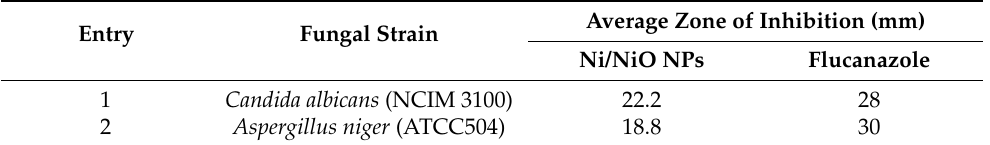
Figure 9. Antifungal effect of biologically synthesized Ni/NiO NPs against ( a ) Candida albicans ( b ) Aspergillus niger and comparative effect of fluconazole (control) against ( c ) Candida albicans ( d ) Aspergillus niger . Table 1. Antifungal effect of biogenically produced Ni/NiO NPs using leaves extract of Gymnema sylvestre .